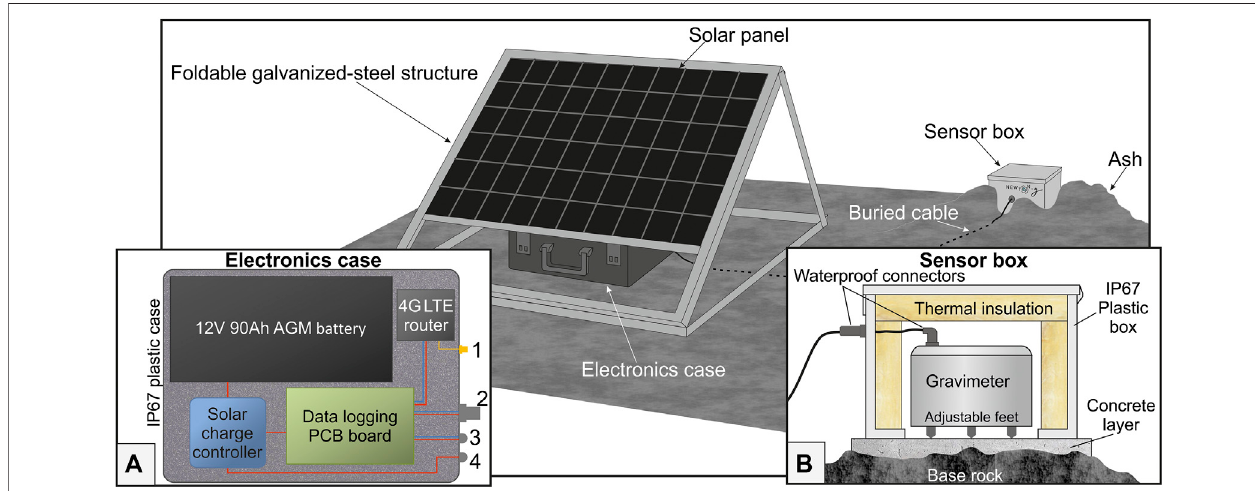
FIGURE 10 | Scheme showing the con fi guration of the typical microelectromechanical systems station in the fi eld. The main elements of the installation are: i) the foldable steel structure holding the solar panel; ii) the electronics case that contains the acquisition system, the router, the battery and the solar charge controller; iii) the sensor box, hosting the gravity sensor. Inset A: detail of the electronics case showing the devices it contains. Connectors on the right route signal (blue lines) and/or power (red lines) to or from: 1 - router antenna; 2 - gravimeter; 3 - soil moisture probes; 4 - solar panel. Inset B: cross-section across the sensor box. Where possible, the sensor box will be covered with ash, to improve overall thermal